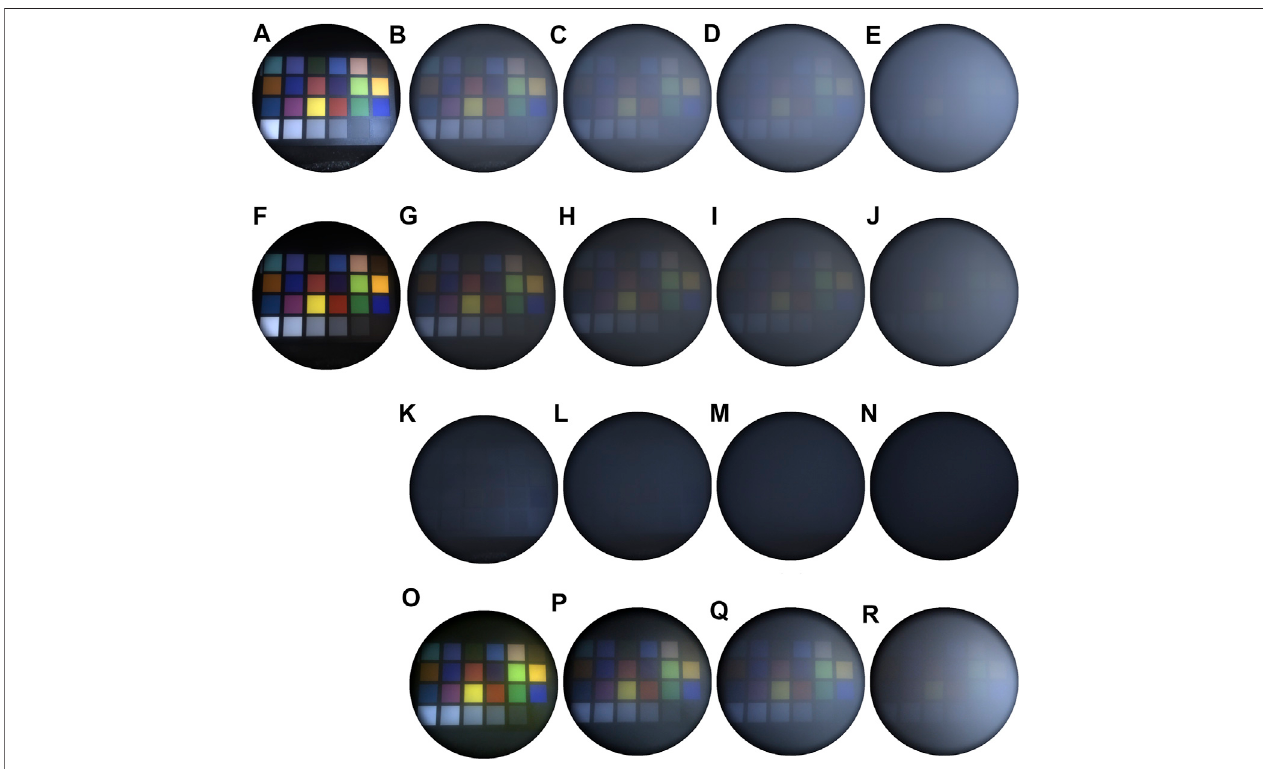
FIGURE 9 | The results of linear polarimetric imaging: the intensity of co-polarized (A) and cross-polarized (F) in smoke-free scenario, the intensity of co-polarized (B – E) andcross-polarized (G – J) channelsatfourdifferentconcentrations,thecorrespondingpolarizationdifferenceresults (K – N) andvisibilityrestorationresults (O – R) .